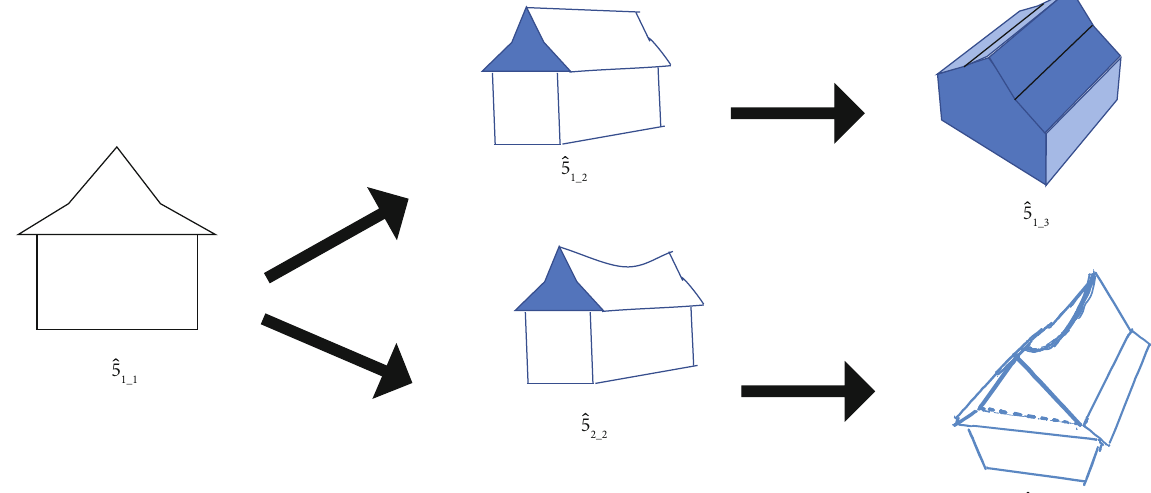
Figure 53: The construction of building number b 5